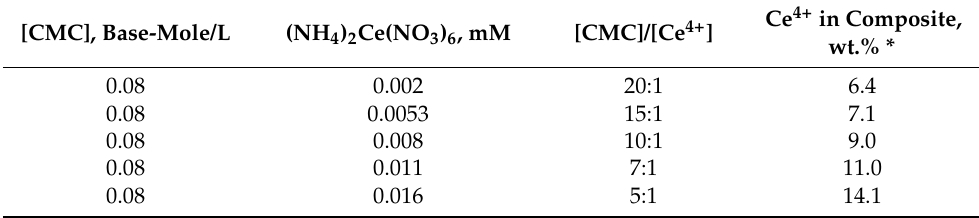
Table 1. Composition of the reaction mixture for the synthesis of cerium-containing nanoparticles and Ce 4+ yield. [CMC],